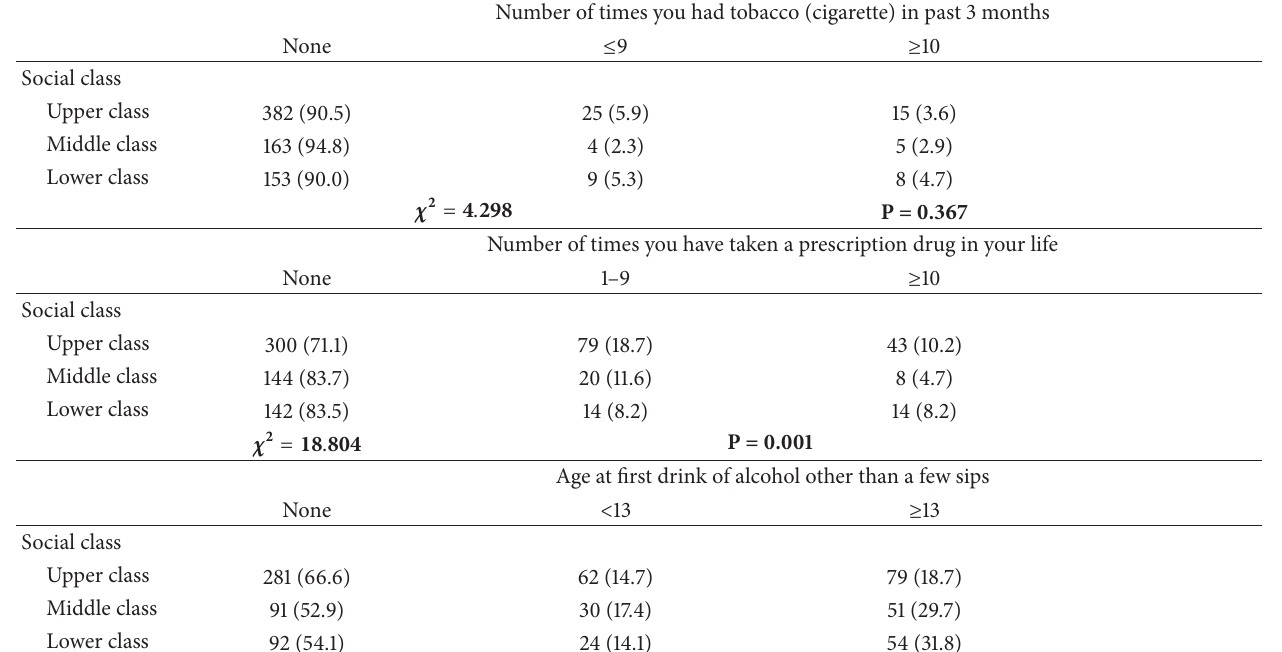
Table 5: Associations of social class with adolescent